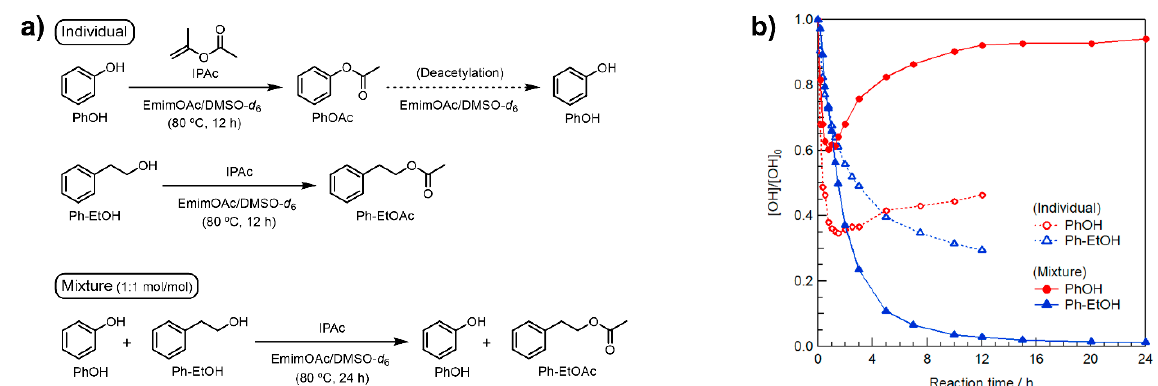
Figure 1. ( a ) Schematic representation of model reactions in EmimOAc/DMSO-d 6 : transesterification of PhOH, Ph-EtOH, and an equimolar mixture using IPAc as an acyl donor. ( b ) Effect of minimal amounts of IPAc and EmimOAc (0.38 mol L − 1 each) on the transesterification of individual PhOH and Ph-EtOH or their mixture (0.38 mol L − 1 each) for 12 or 24 h at 80 °C determined as changes in relative contents by in situ 1 H NMR in DMSO- d 6 .